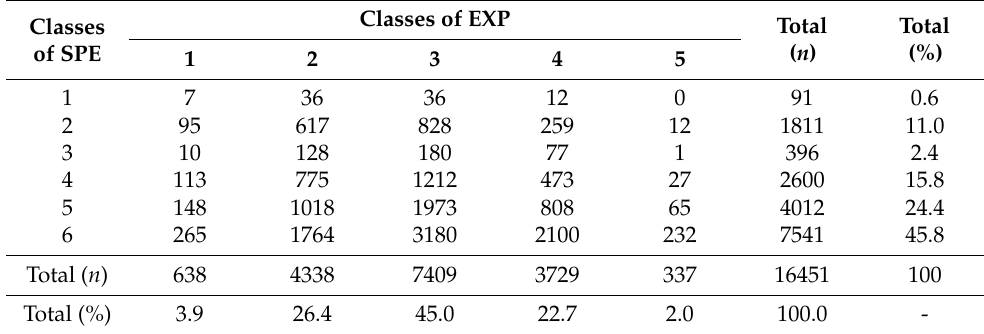
Table 9. The LAU’s number for each combination of the five EXP classes and six SPE classes for data of the second census date (C2).